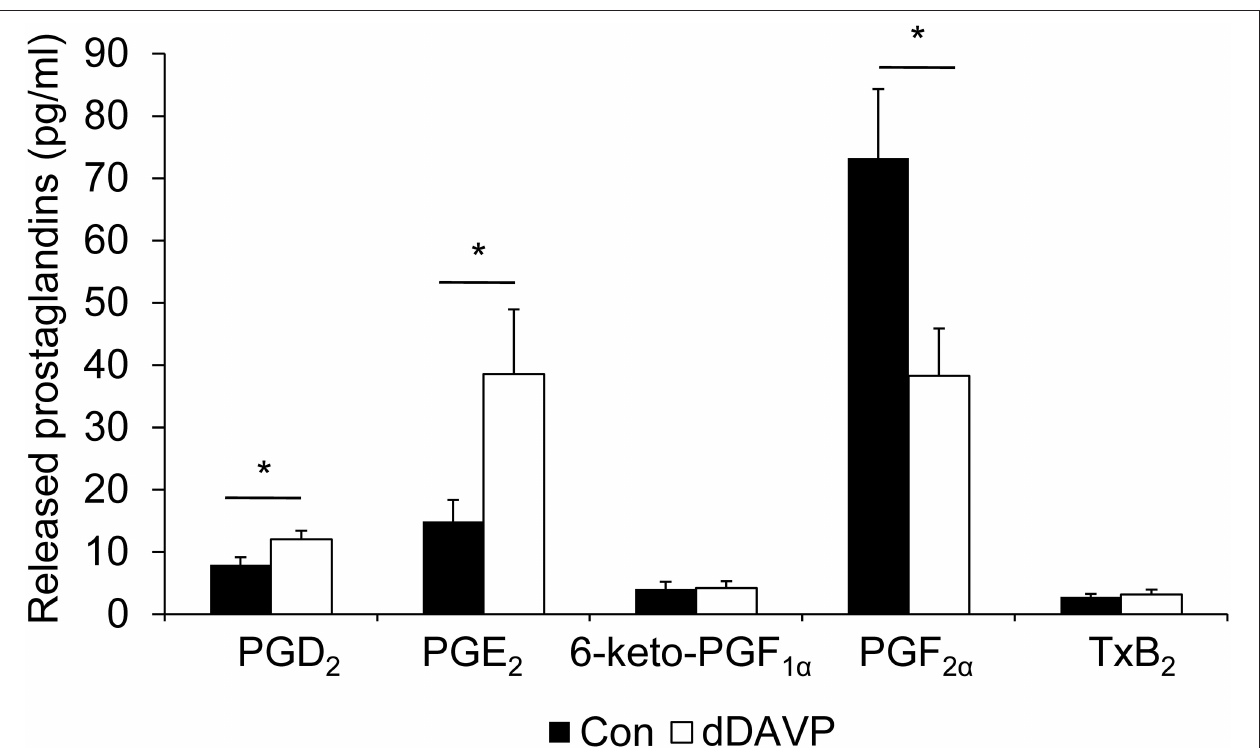
FIGURE 3 | Effect of dDAVP on prostaglandin production. MpkCCD c14 cells were grown for 8 days and treated with or without (con) 1nM dDAVP for the last 4 days. The medium from both sides, incubated with the cells for 24h, was collected, and prostaglandin concentrations were determined. Bars are mean values of eight filters per condition ( ± SEM). Significant differences from control ( p < 0.05) are indicated by an